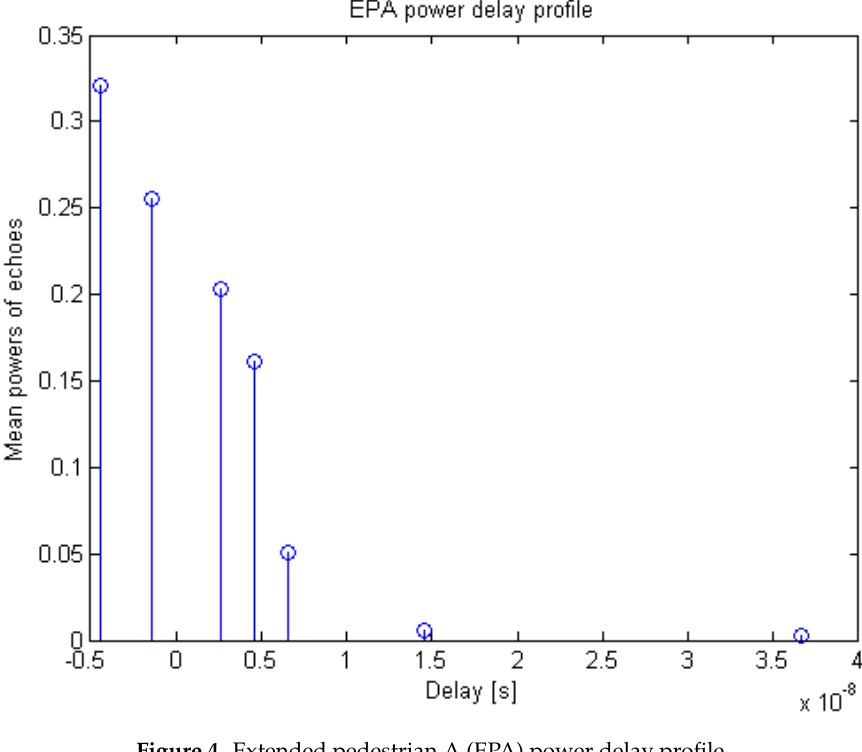
Figure 4. Extended pedestrian A (EPA) power delay profile.